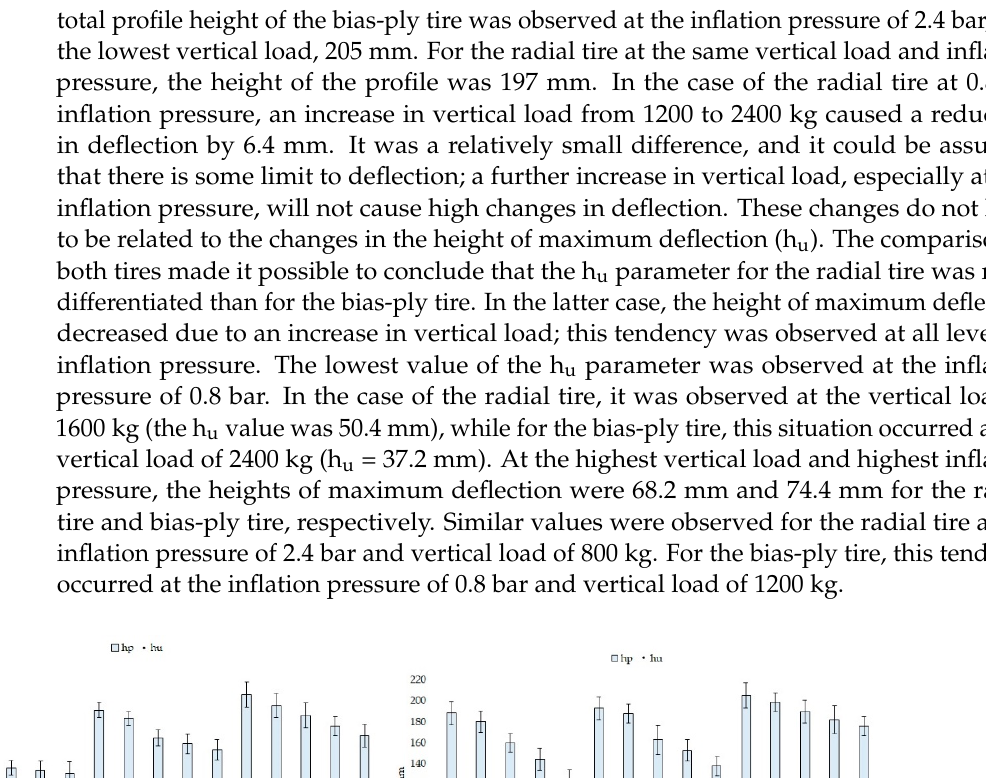
( b ) Figure 6. Visualization of horizontal cross-sections according to inflation pressure and vertical load: radial tire ( a ); bias-ply tire ( b ). The parameters read from horizontal cross-sections were their total area (A hu ) and the width (b hu ). Figure 7 shows the values of the area of horizontal cross-sections. The highest values of the parameter were observed for both tires at the highest vertical load (2400 kg) and the lowest inflation pressure (0.8 bar). The areas were 0.325 m 2 and 0.316 m 2 for the radial and bias-ply tire, respectively. At the highest (2.4 bar) and lowest (0.8 bar) inflation pressures for each vertical load, higher cross-section areas were observed for the radial tire. Only in the case of the inflation pressure of 1.6 bar and vertical load of 800 kg was the area of cross-section higher for the bias-ply tire.